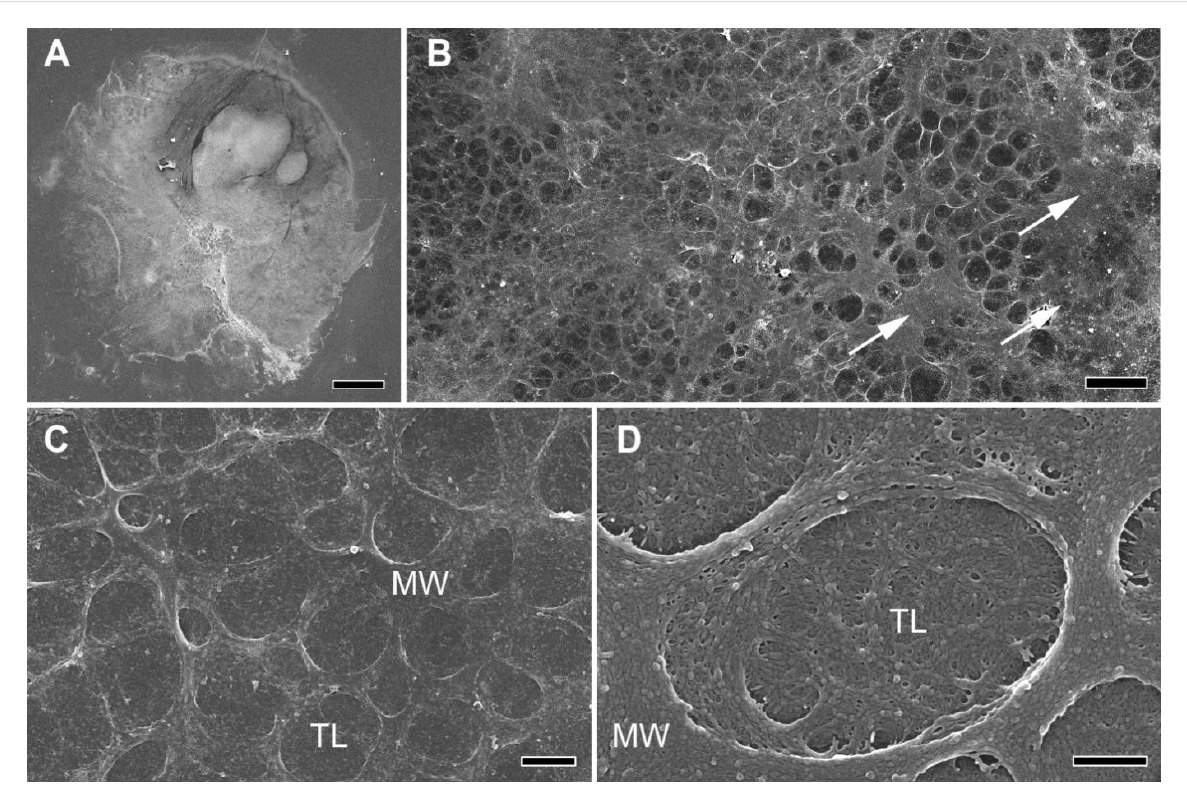
Figure 4: Scanning electron microscopy of footprints in Asterina gibbosa . (A) Overview of a complete footprint. (B) Characteristic area of a footprint with visible meshwork. Arrows indicate thicker parts, where the meshwork is not distinguishable. (C,D) Details of the meshwork at higher magnifica- tions. MW - meshwork; TL - thin layer. Scale bars: (A) 100 µm; (B) 10 µm; (C) 2 µm; (D) 0.5